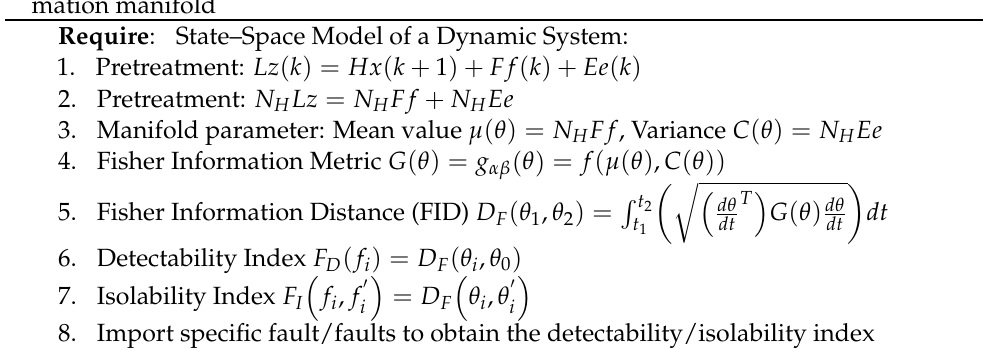
Algorithm 1: The quantitative evaluation method for diagnosability on an infor- mation manifold